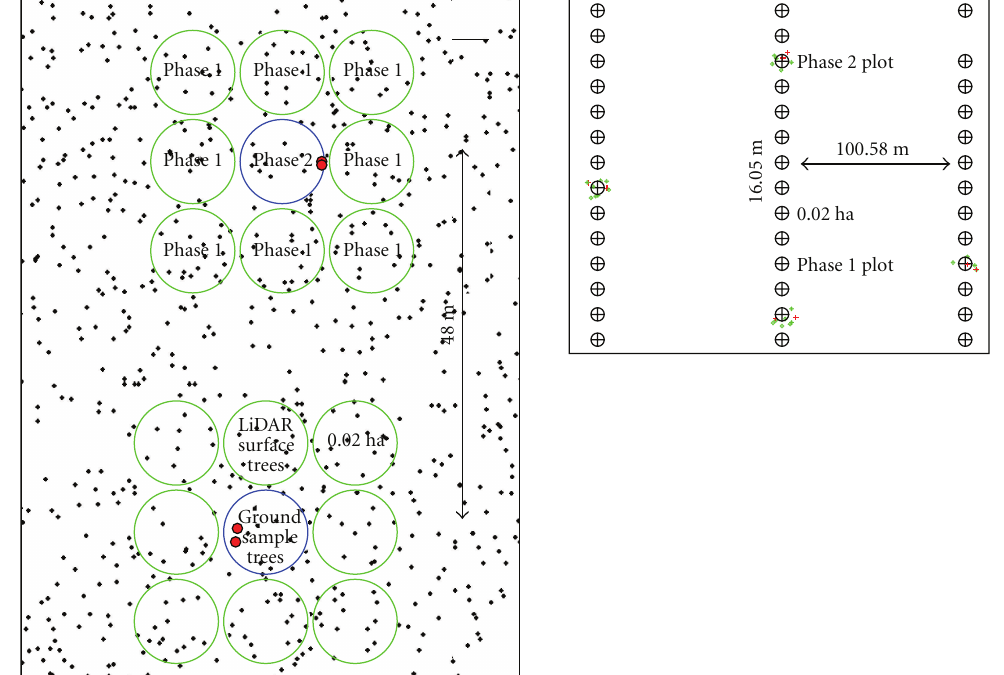
Figure 1: Sample designs for 0.02ha plots with 9 : 1 and 10 : 1 ratios of LiDAR plots (Phase 1) to ground (Phase 2) circular plots in a nested arrangement and plots along a flight